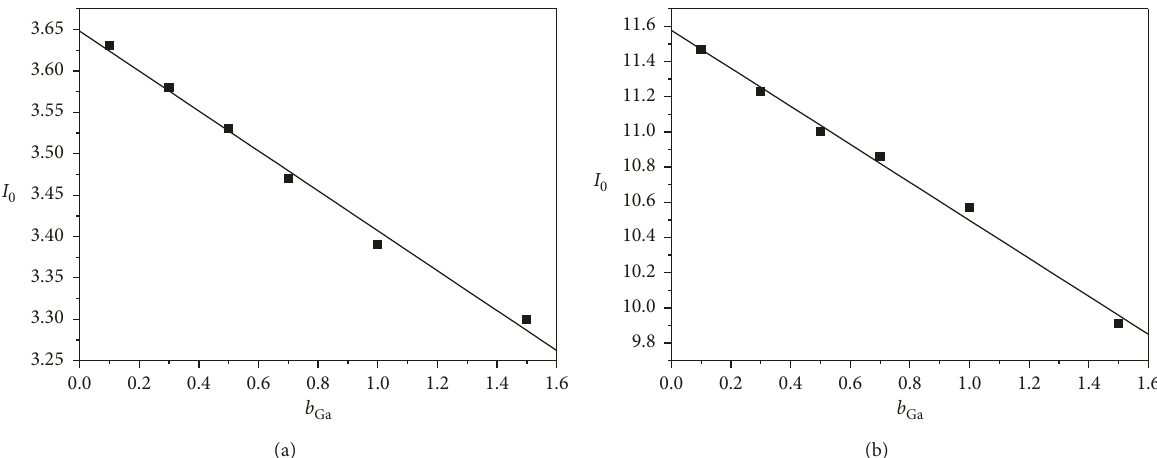
Figure 3: Typical plot of I o against b Ga for the CO (a) and CN (b) stretching bands of non-coordinated FA